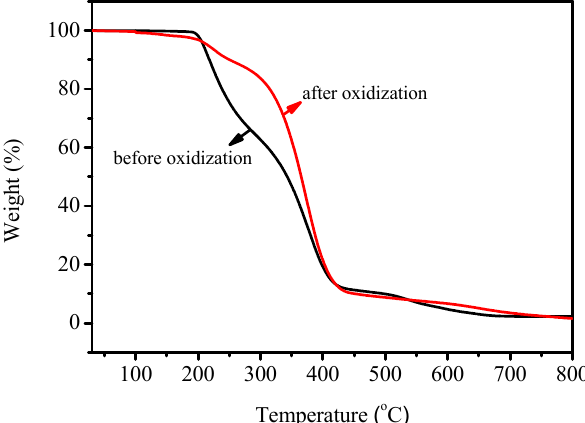
Figure 7. Thermogravimetric analysis (TGA) spectra of copolymers before and after oxidization.